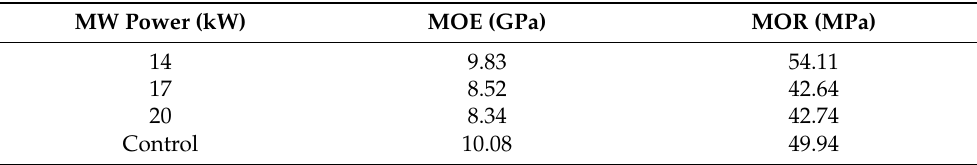
Table 8. MOE and MOE of MW-treated samples of Chinese fir wood found by